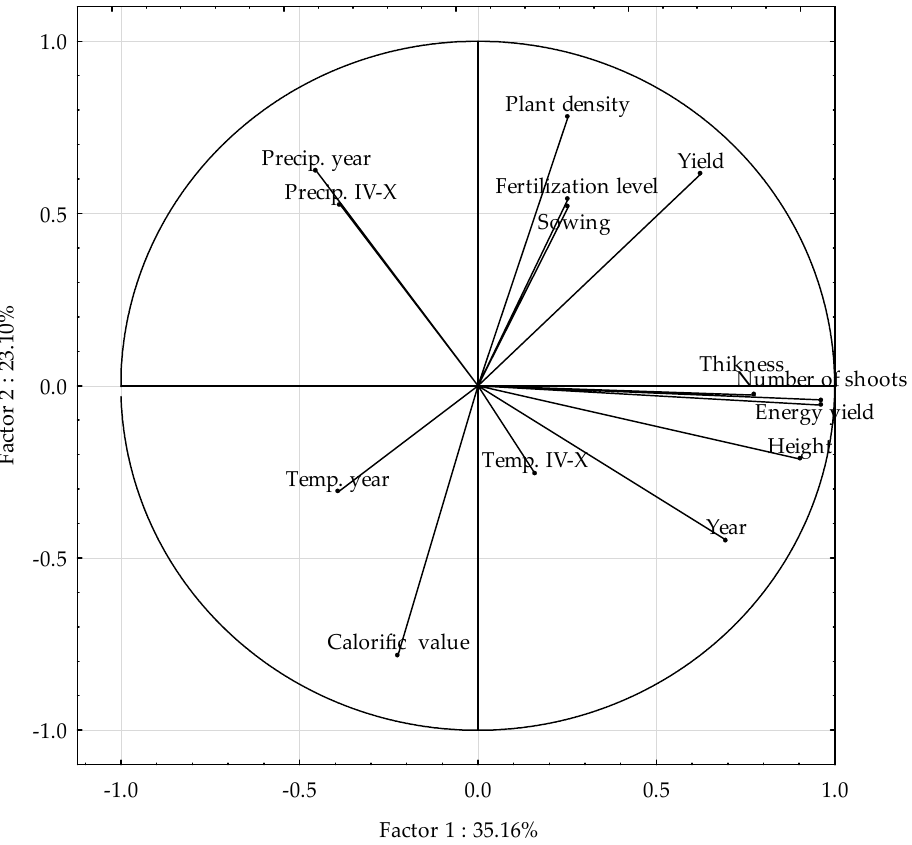
Figure 2. The principal component analysis (PCA) for Sida DMY, biometric parameters, energetic parameters and climatic conditions.